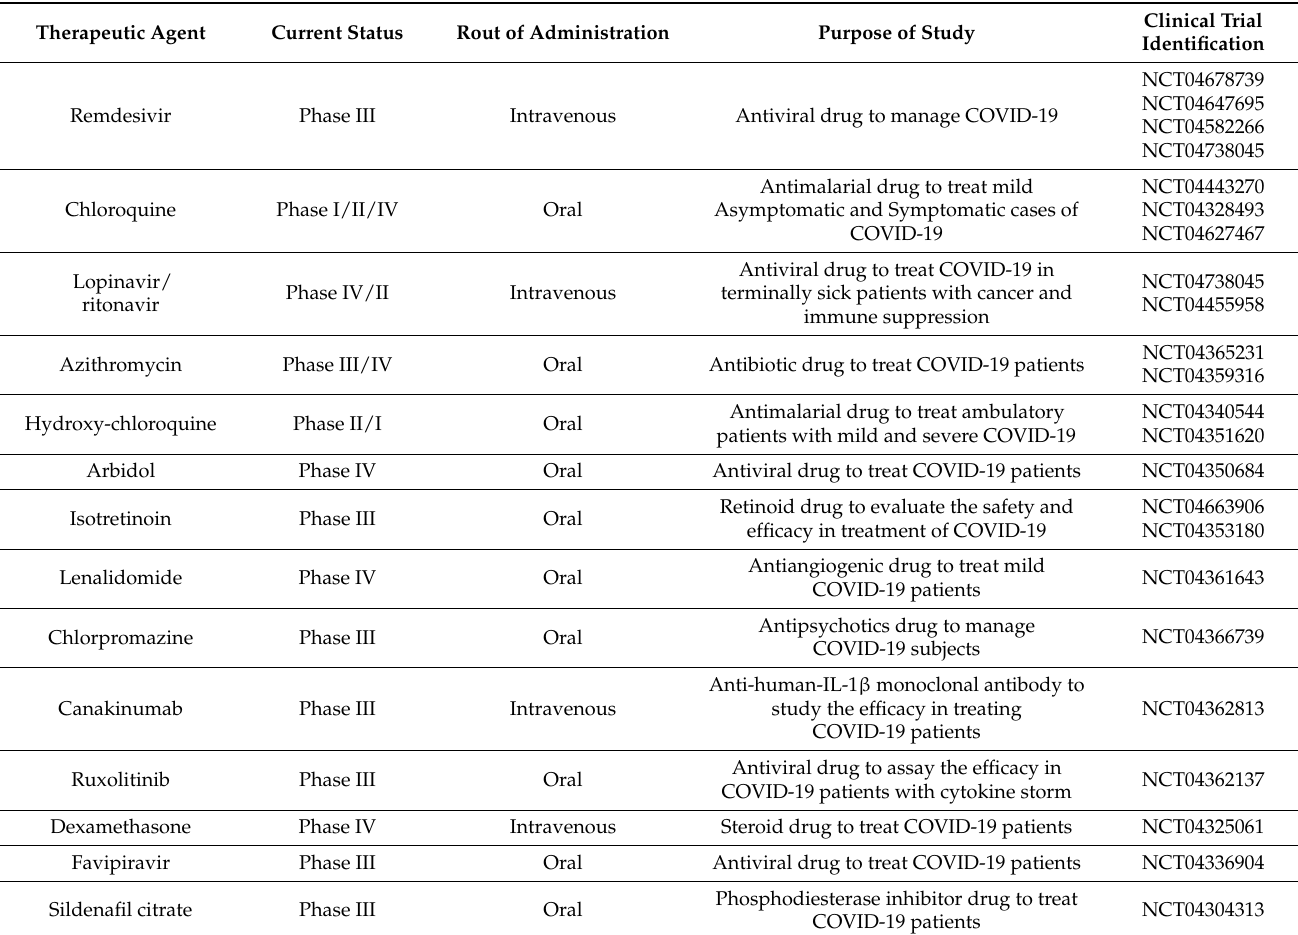
Table 2. Summary of the drugs for combating COVID-19 that are under clinical